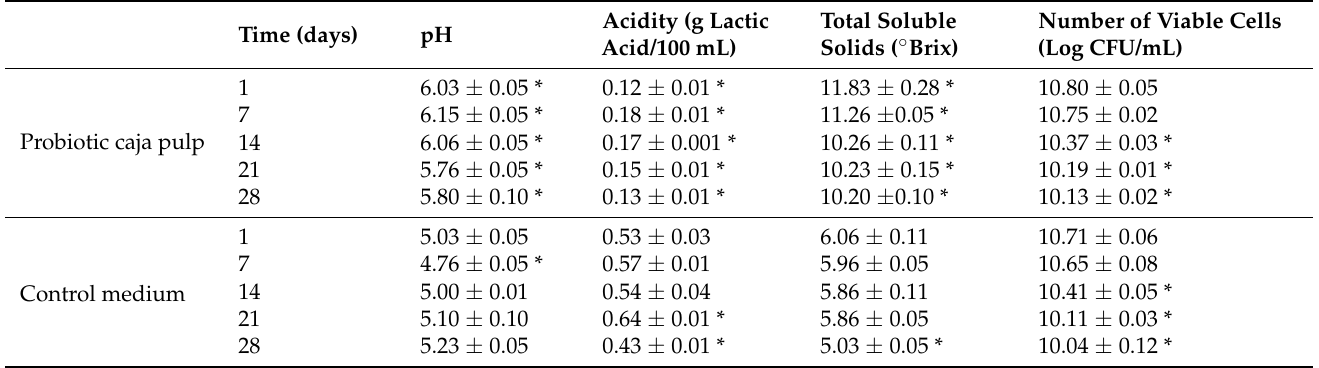
Table 3. Results of the physicochemical characterizations during the storage period of caja probiotic pulp and the control medium were obtained after 22 h of